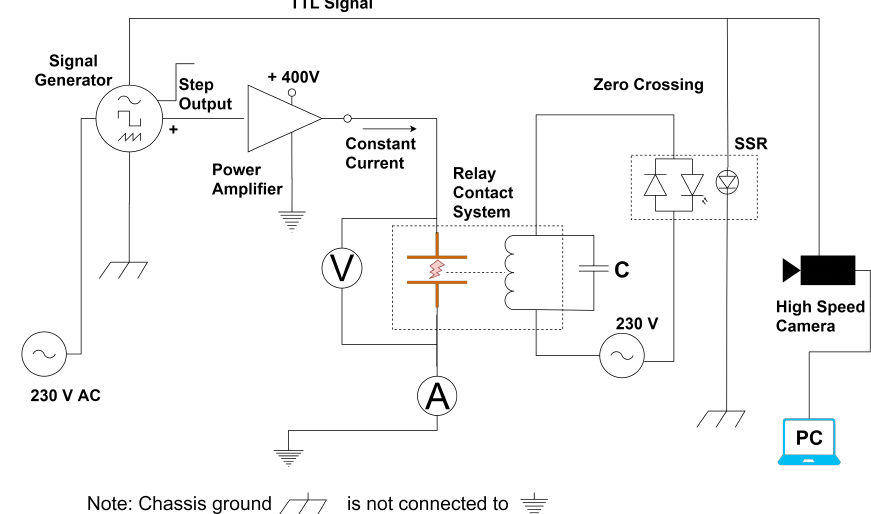
Figure 2. Schematic of the circuit